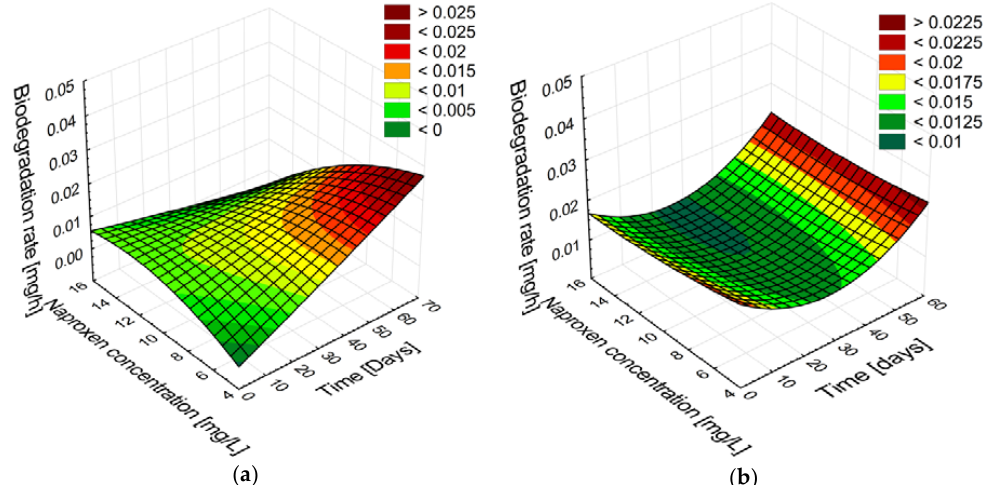
Figure 3. Naproxen (6, 9, 12 and 15 mg/L) biodegradation rate by ( a ) free cells of Planococcus sp. S5; and ( b ) immobilized on loofah sponges cells of Planococcus sp. S5; presented as patterns and the relationships among the time of incubation, naproxen concentration and biodegradation rate.